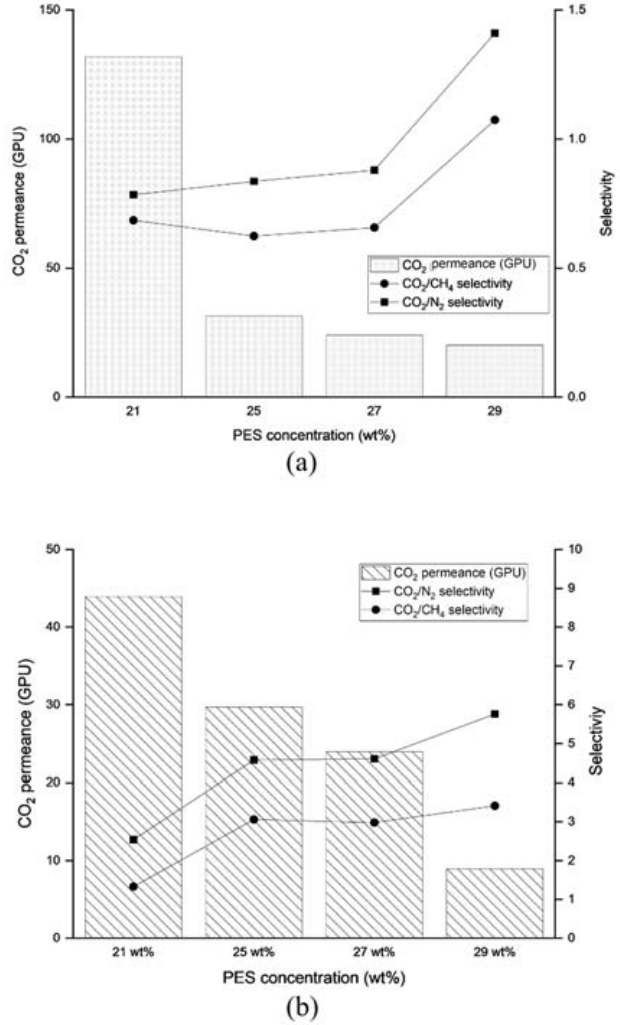
Figure 7. Separation performance of ( a ) uncoated PES substrate and ( b ) coated PES.